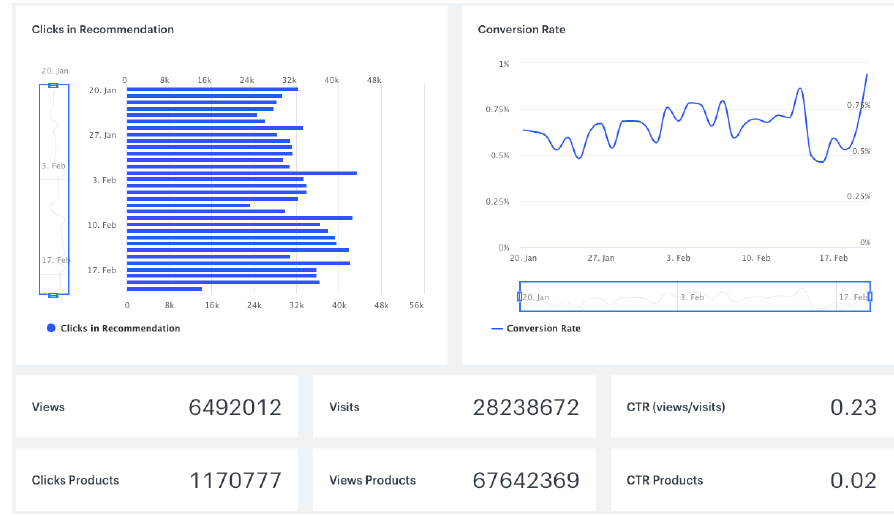
Figure 6. Recommendation analytics interface—aggregated results.